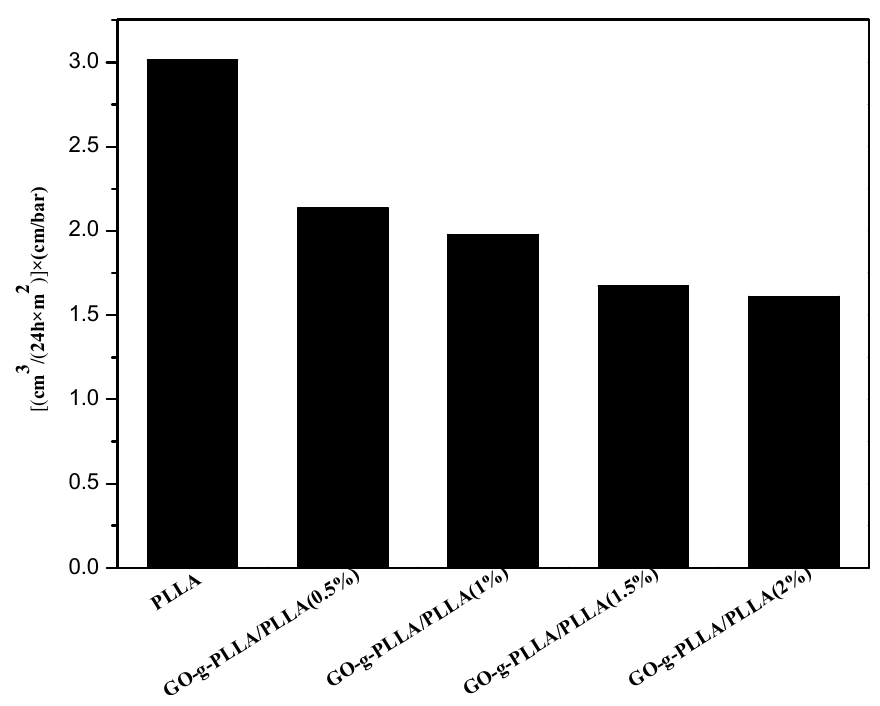
Figure 13. PLLA and GO- g -PLLA/PLLA oxygen permeability (PO 2 ) results.